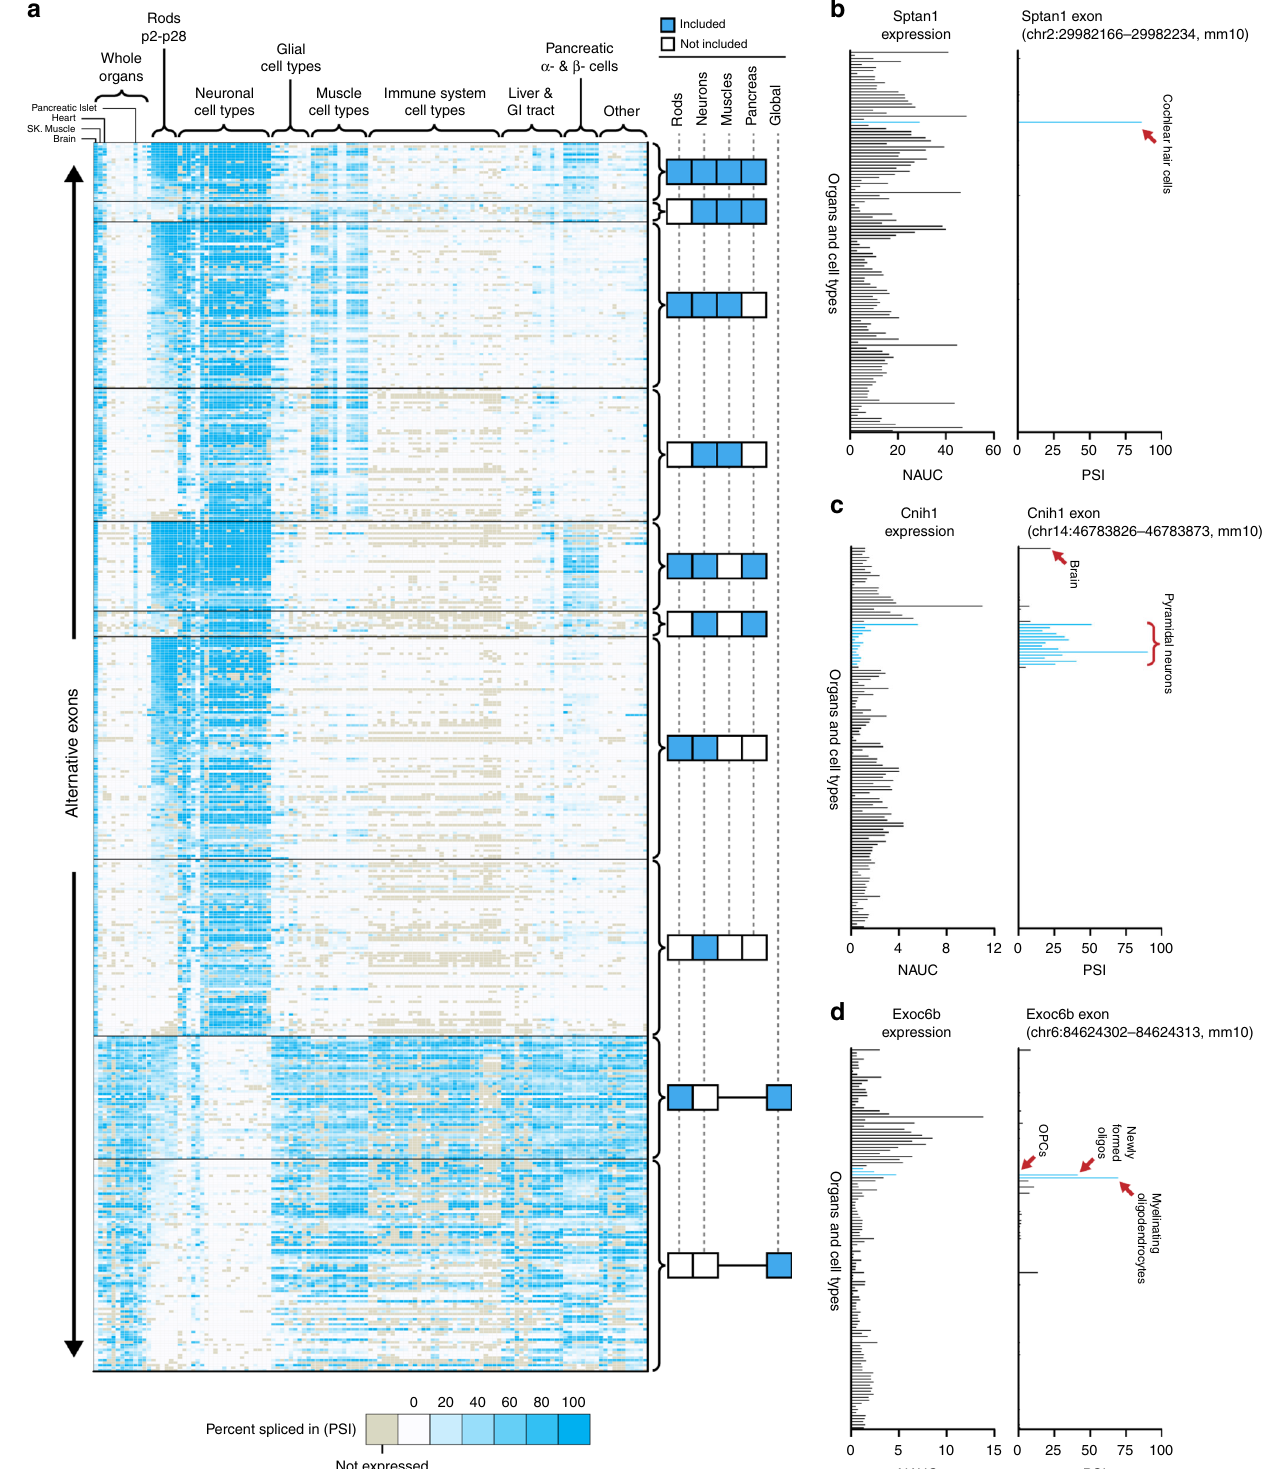
photoreceptor-speci fi c exons revealed only 31 splicing events (found in 28 genes) that were common between both species. These 28 genes generally fall under pathways of cilia formation, neuronal connectivity and various metabolic pathways. Likewise, mutations in several genes are linked to retinitis pigmentosa or intellectual disability, underscoring their functional importance (Fig. 2c). Among the 31 rod-speci fi c splicing events, 17/31 have